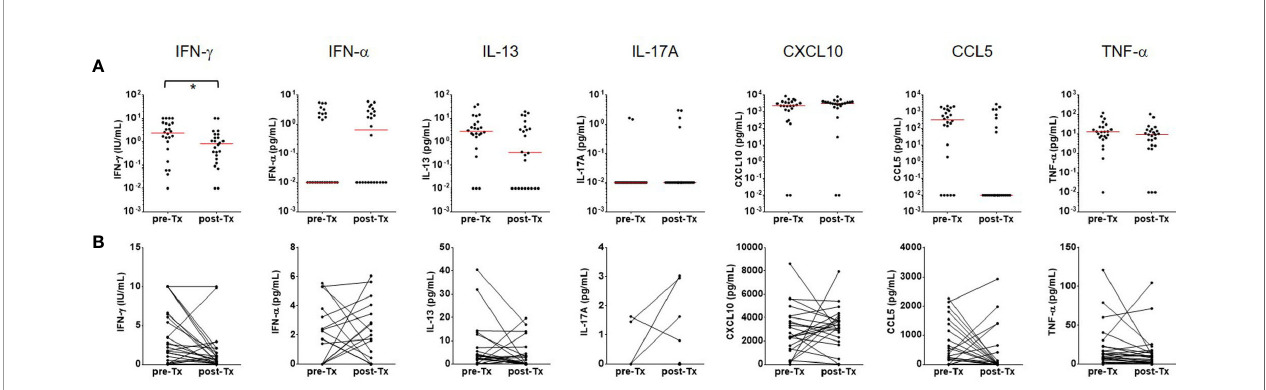
FIGURE 5 | Follow-up immune responses to the Beijing/K-peptide combination after TB treatment. (A) Distribution of cytokines and chemokines as immune responses to the Beijing/K-peptide combination after TB treatment. The median responses are marked by red lines. (B) Longitudinal analysis of cytokine and chemokines after TB treatment. Signi fi cant decreases in IFN-g response to the MTBK antigen were observed in 24 TB patients who fi nished anti-TB treatment. Other cytokines and chemokines tested in this study did not show signi fi cant changes after treatment (antigen minus nil). *P < 0.05 by Wilcoxon signed rank test,